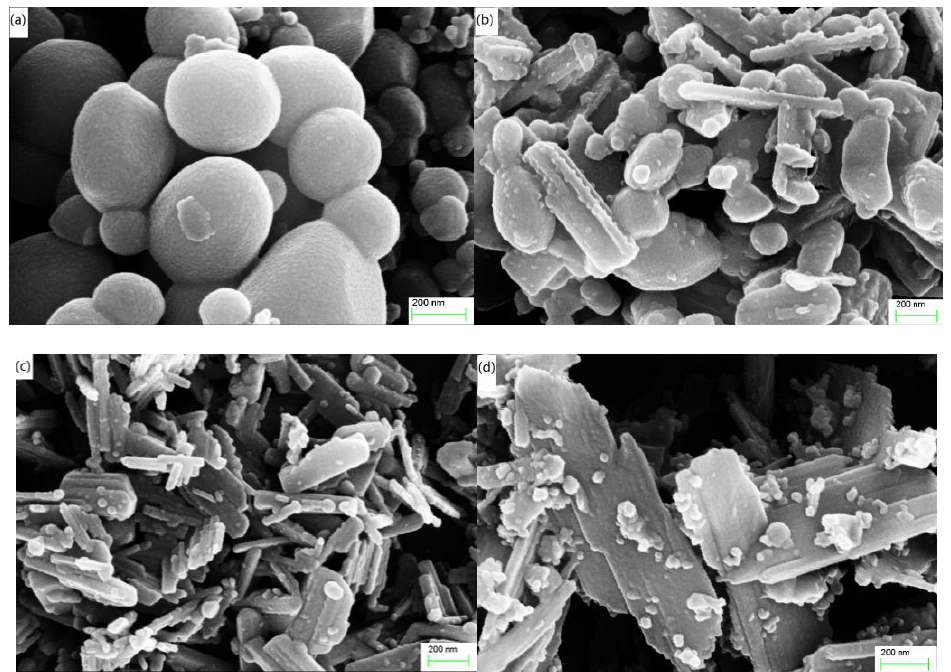
Figure 2. ( a – d ) FE-SEM (field emission scanning electron microscope) micro-topographic images of the un-doped, 1% Zr-doped, 2% Zr-doped and 4% Zr-doped VO 2 samples, respectively. All images were observed in InLens mode with an accelerated voltage of 15 kV.